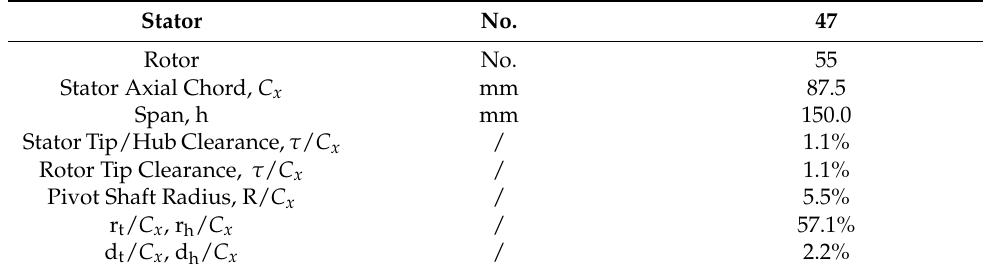
Table 1. Parameters of the low-pressure turbine.